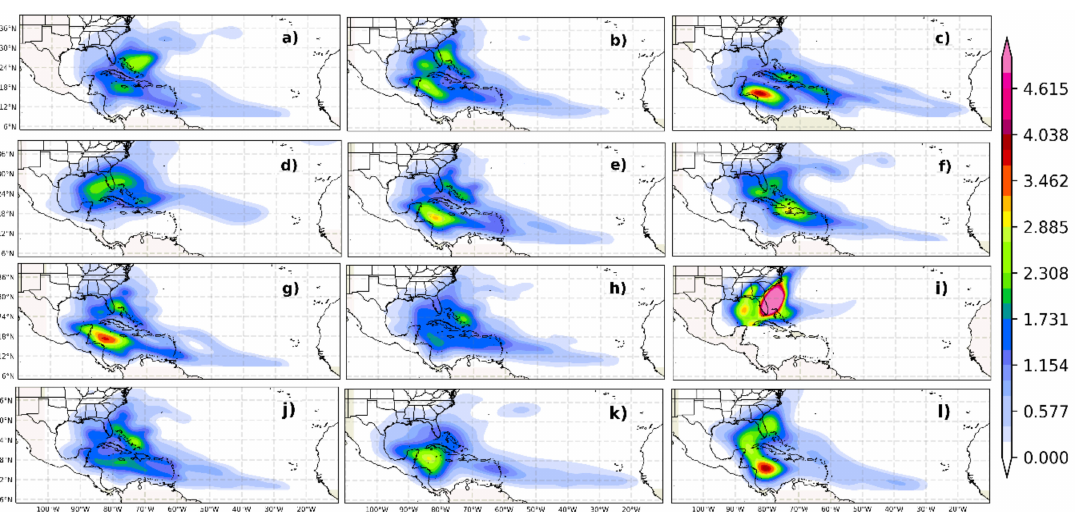
Figure 5. Density (10 − 3 ) of TCs trajectories that a ff ected Cuba during the positive, neutral and negative phases of El Niño Southern Oscillation (ENSO) ( a – c ), North Atlantic Oscillation (NAO) ( d – f ), Atlantic Meridional Mode (AMM) ( g – i ), and larger and smaller Atlantic Warm Pools (AWPs) ( j – l ). Period: